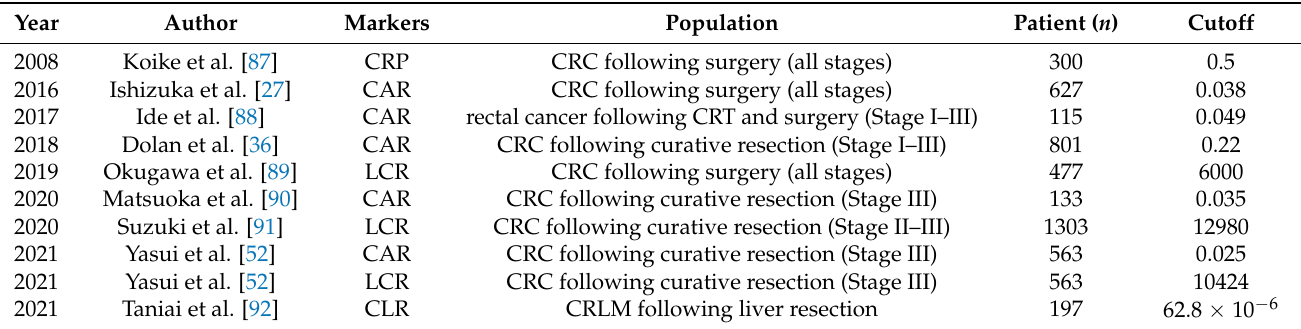
Table 5. CRP-related markers in previous reports on colorectal